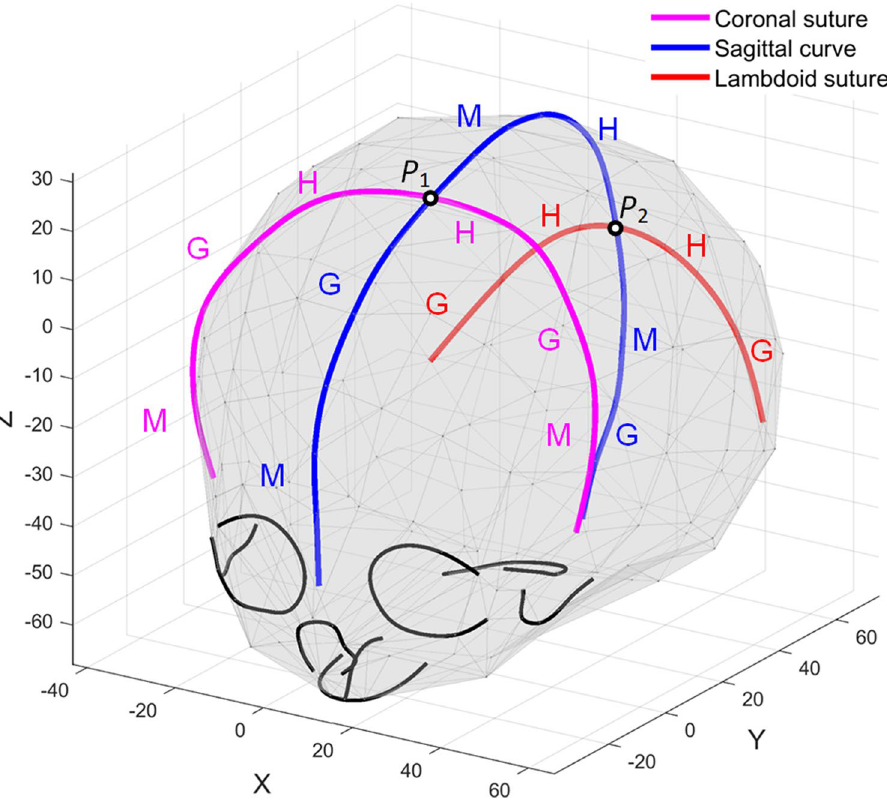
Figure 13. The location of the coronal suture (magenta), sagittal curve (blue) and the lambdoid suture (red) on a human infant skull. The intersection points between sutures, P 1 and P 2 , divide the sagittal curve into three sub- profiles and the lambdoid suture into two